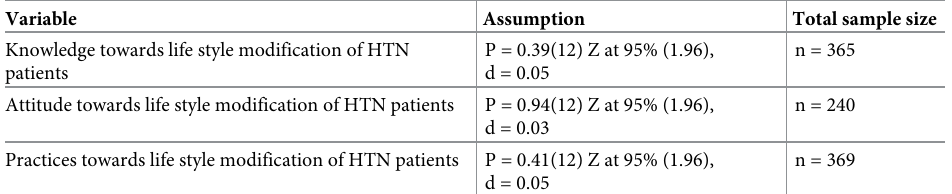
Table 1. The minimum total sample size calculations for the knowledge, attitude and practices of the hypertensive patients’ lifestyle